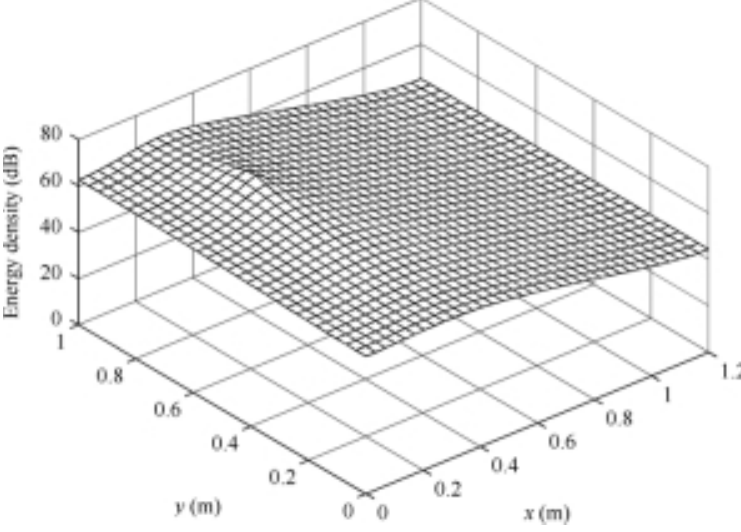
Fig. 24. The approximate energy density distribution of the orthotropic plate with L x = 1 . 2 m and L y = 1 m when x o = 0 . 3 m, y o = 0 . 7 m, f = 5 kHz and η = 0 . 1 . The reference energy density is 1 × 10 − 12 J/m 2